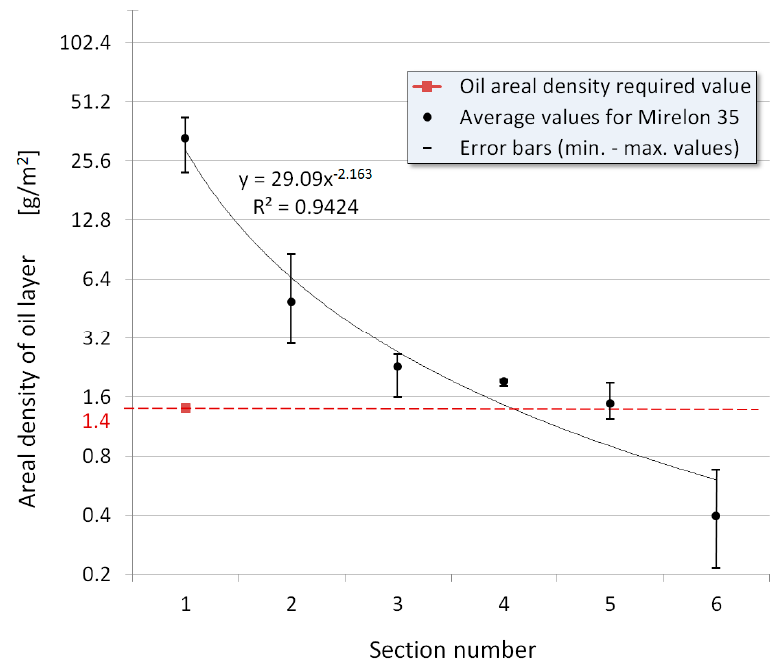
Figure 19. Graphical representation of average oil film weights in individual sections of coated Mirelon 35 pipes. Data is downloaded from Table